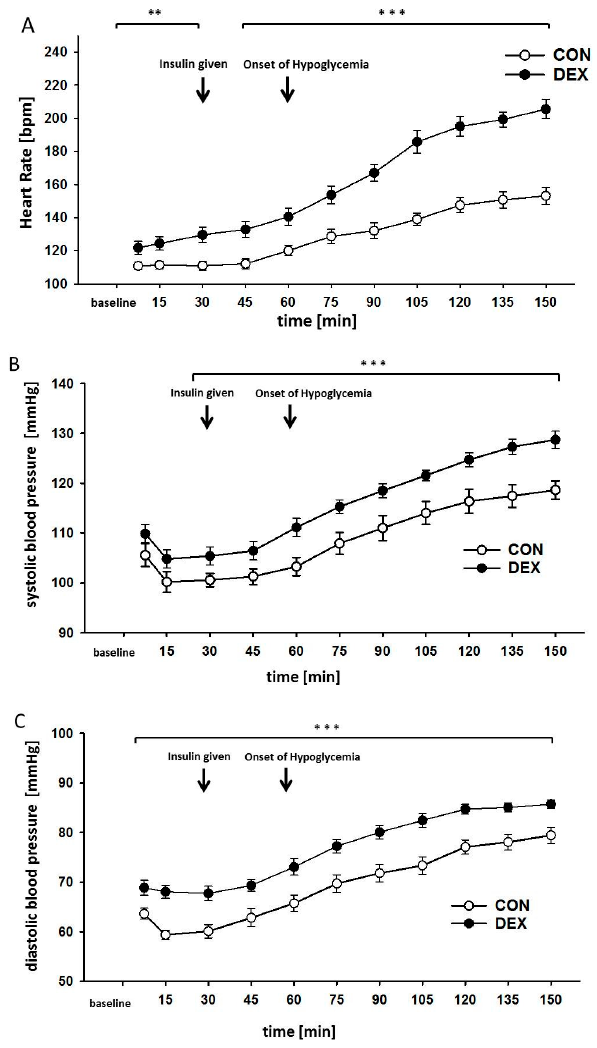
Figure 2. Effects of hypoglycemia on vital parameters. ( A ) Heart rate; ( B ) systolic and ( C ) diastolic arterial blood pressures. Data are given as mean ± SEM for the control group (CON) and the dexamethasone-treated group (DEX), ** p < 0.03, *** p < 0.001.